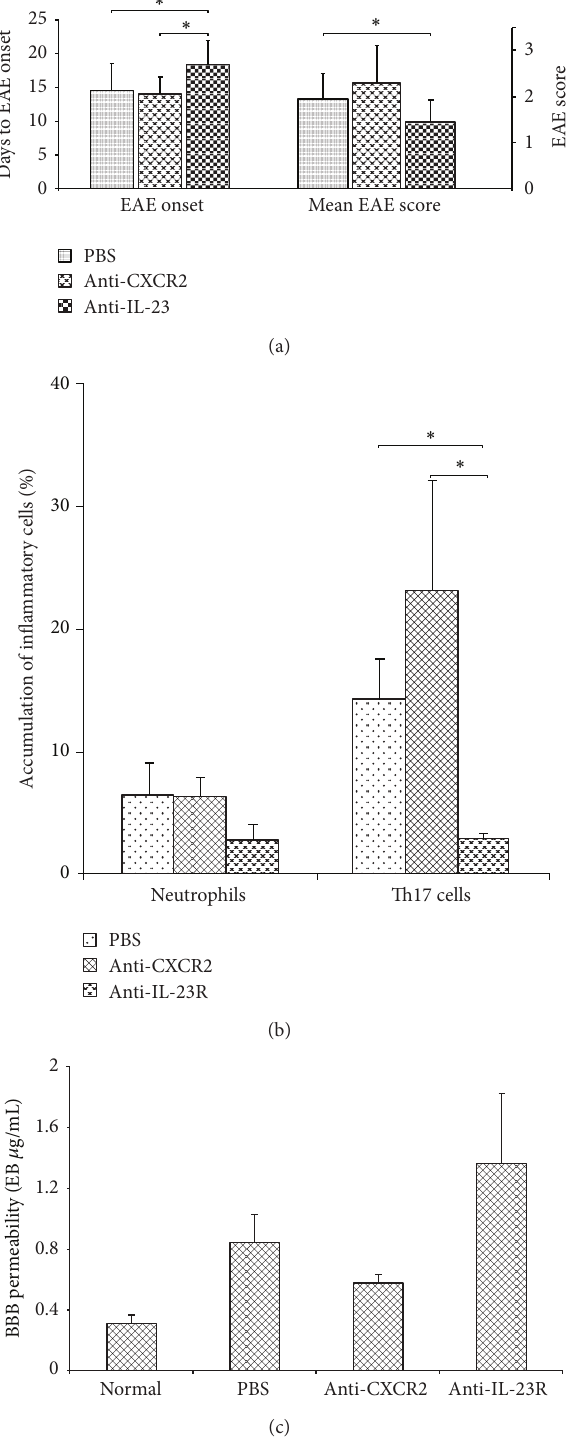
Figure 4: Modulation of EAE by anti-CXCR2 or anti-IL23R anti- bodies. (a) Mean time to EAE onset and mean EAE score at day 2 of the attack, (b) accumulation of Th17 cells and neutrophils in the brain, and (c) BBB permeability. Accumulation of inflammatory cell subpopulations was analyzed at the second day of EAE using flow cytometry; BBB permeability was analyzed at the same time point using Evans blue dye as described in Materials and Methods. Data are presented as mean ± SEM. ∗ 0.05 ≥ 𝑃 ≥ 0.01